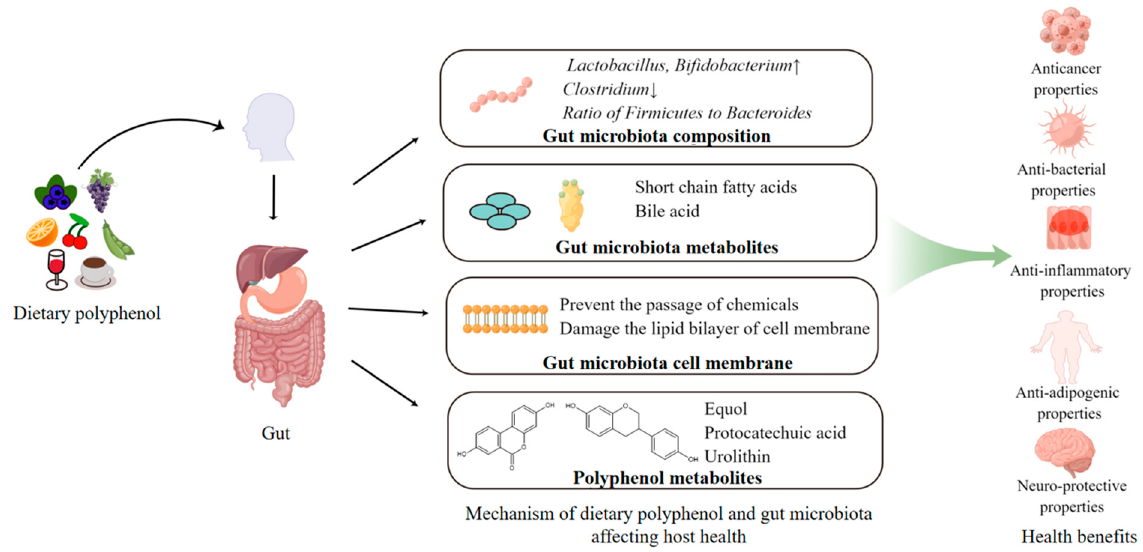
Figure 2. Possible mechanisms among dietary polyphenols, gut microbiota, and host